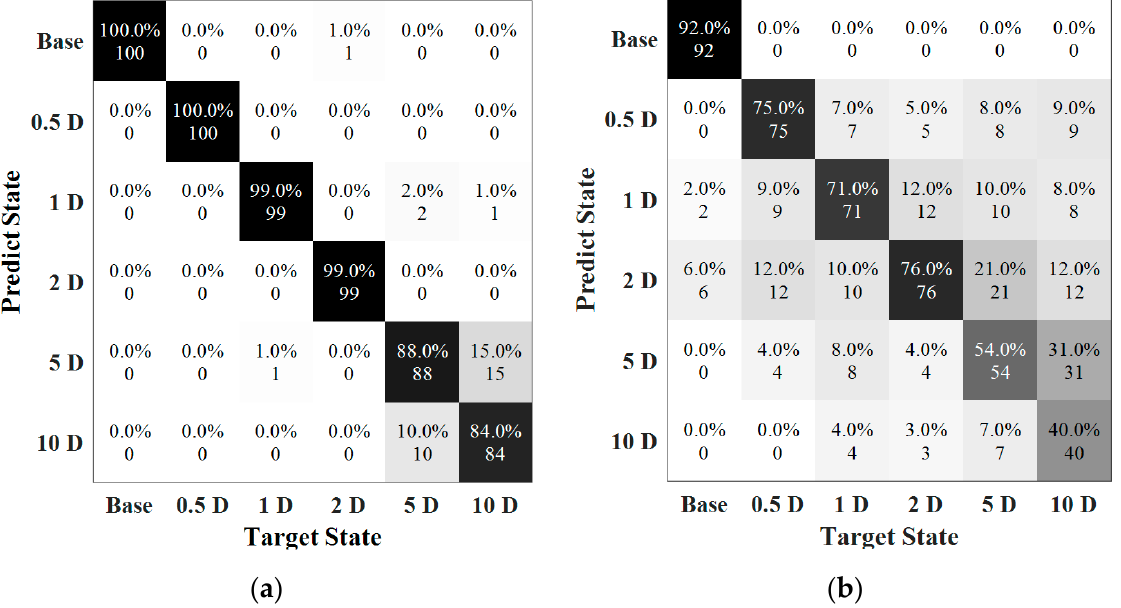
( b ) Figure 22. Locations identification in pipeline. ( a ) Location detects without welding defect. ( b ) Location detects with welding defect 5.2. Classification Performance for Case 3: Detection of Weld Defect Types 5.2.1. Training and Validation Results of Weld Defect Types Welding defect detection is crucial to ensure structural integrity. Several defects, such as lack of fusion, cracks, undercut, and lake of penetration are easily formed during the manufacturing process. Four different welding defects shown in Table 1 (State #10, 12~14) and the reference state (State #1) were composed as the training set when the SNR ranged